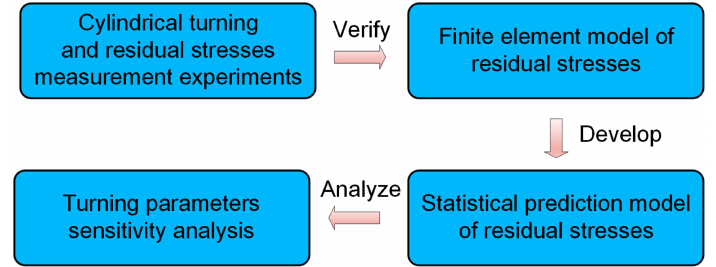
Figure 1. The synoptic realization steps of the proposed residual stresses prediction